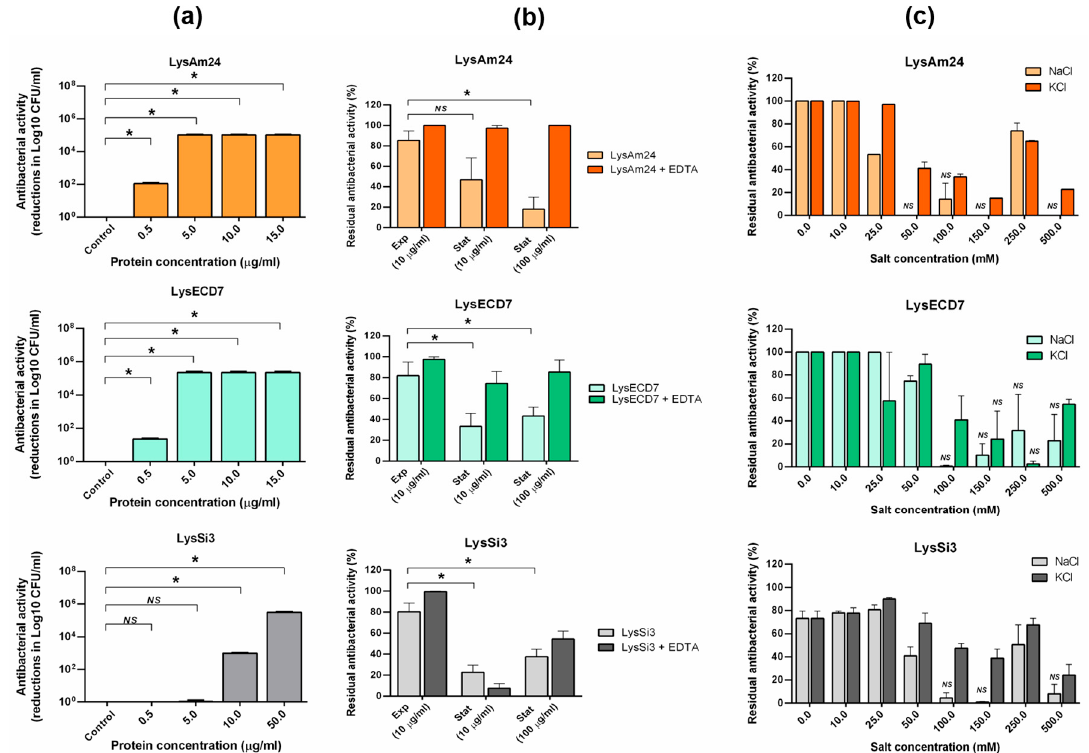
Figure 2. Bactericidal activity and biochemical properties of LysAm24, LysECD7, and LysSi3. ( a ) Bactericidal activity of different concentrations of LysAm24 against A. baumannii Ts 50-16, LysECD7 against E. coli M15 and LysSi3 against the A. baumannii Ts 50-16 in exponential phase. Cell cultures without incubation with endolysins were used as controls. The number of surviving cells after 18 h is expressed as reduction in log10 CFU/mL compared to the control. NS, no statistical significance of the data compared to the untreated culture is observed ( p > 0.05, Mann–Whitney test). ( b ) Activity of lysins against both exponentially growing cells (Exp) and stationary-phase cells (Stat) of A. baumannii Ts 50-16 without and in the presence of EDTA. The residual activity after 18 h of growth compared to the untreated culture is shown. NS, no statistical significance of the data compared to the exponential growth phase is observed ( p > 0.05, Mann–Whitney test). ( c ) Effects of salts on the bactericidal activity against A. baumannii Ts 50-16. The residual activity after 18 h of growth compared to the untreated culture is shown. NS, no statistical significance of the data compared to the untreated culture is observed ( p > 0.05, Mann–Whitney test). For all experiments, the mean values are shown ( ± standard error of the mean (SEM)) from three independent experiments. Asterisk (*) indicates significant effect on bactericidal activity.